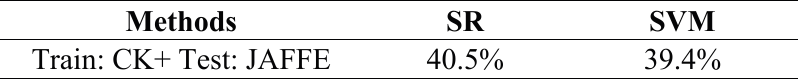
Table 6. Comparisons on across-database between SR and SVM.